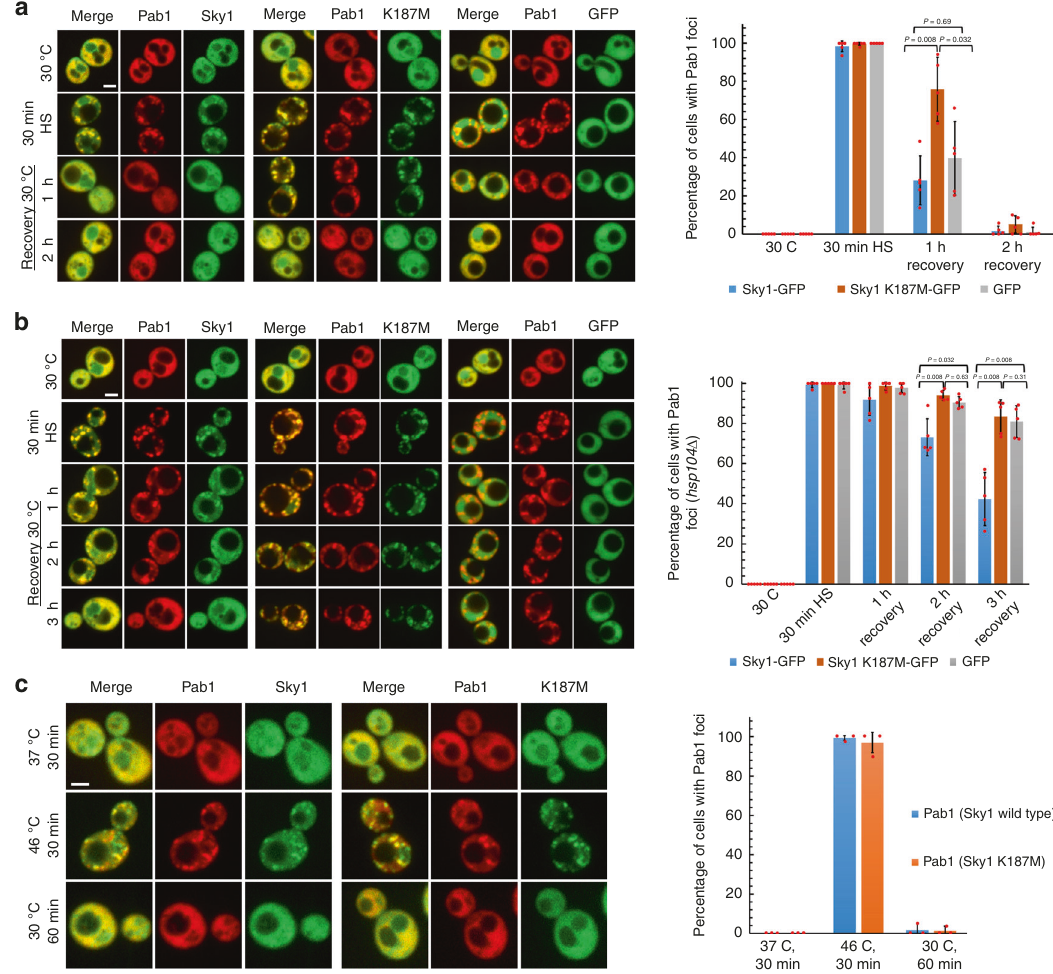
Fig. 6 Sky1 overexpression can compensate for defects in other stress granule dissolution pathways. Either an HSP104 ( a ) or hsp104 Δ ( b ) strain expressing Pab1-mCherry from its endogenous locus was transformed with plasmids expressing Sky1-GFP (blue bars), Sky1 K187M -GFP (orange bars), and GFP (gray bars) under control of the GPD promoter. Cells were grown in synthetic dropout medium and visualized by fl uorescence microscopy during a heat shock and recovery; the percentage of cells containing Pab1 foci was determined. Scale bar, 2 μ m. Data represent means ± SD of n = 5 independent replicates. A two-sided Mann – Whitney U test was used to calculate P values. c Pretreatment with mild heat stress to upregulate chaperone levels compensates for sky1 de fi ciency. Yeast expressing Pab1-mCherry and either Sky1-GFP (blue bars) or Sky1 K187M -GFP (orange bars) from the corresponding endogenous loci were grown to mid-log phase, and then subjected to 37 °C for 30 min to upregulate chaperone levels. Scale bar, 2 μ m. Data represent means ± SD of n = 3 independent replicates. Source data are provided as a Source Data